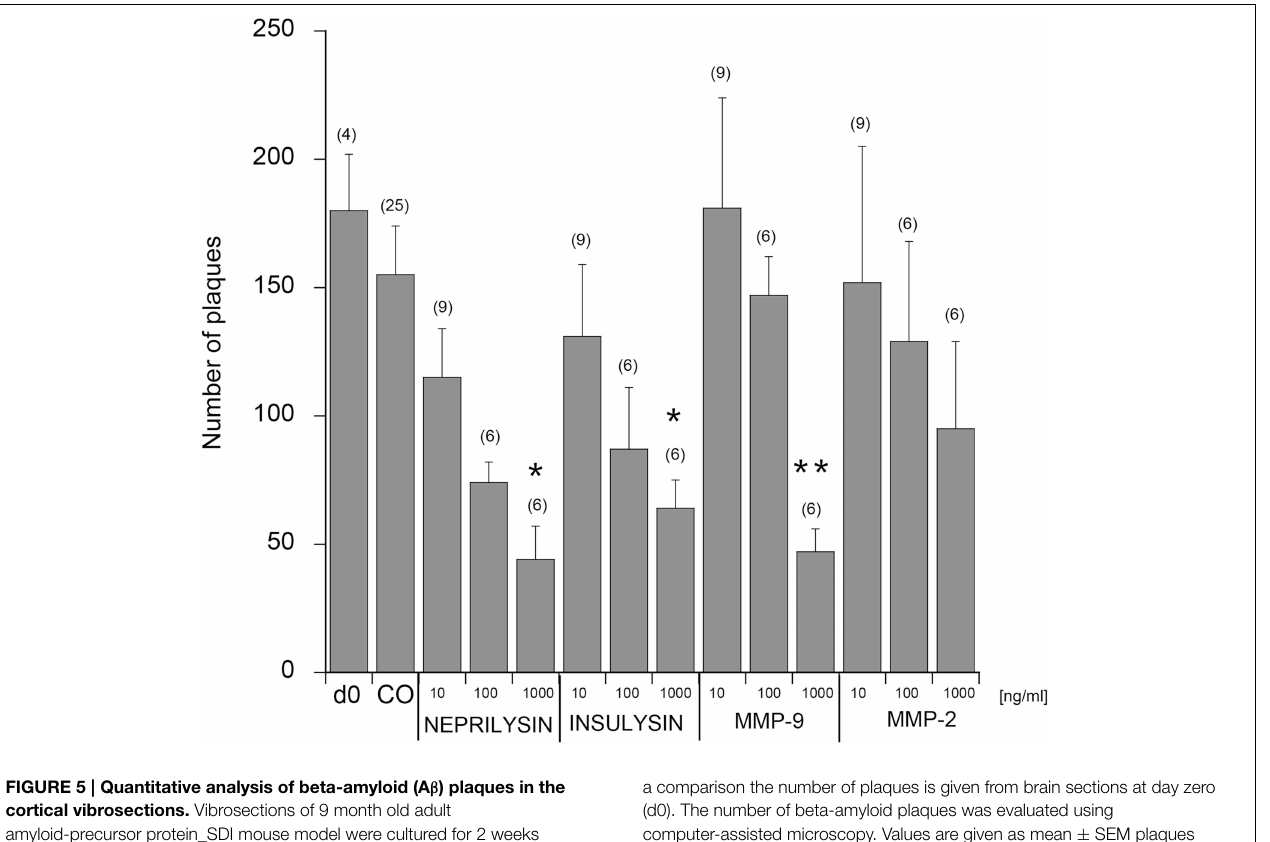
FIGURE 5 | Quantitative analysis of beta-amyloid (A β ) plaques in the cortical vibrosections. Vibrosections of 9 month old adult amyloid-precursor protein_SDI mouse model were cultured for 2 weeks without (CO) or with 10, 100, or 1000ng/ml neprilysin, insulysin, matrix metalloproteinase (MMP) − 2 or − 9. Slices were then fixed and immunohistochemically stained for plaques with a beta-amyloid antibody. As